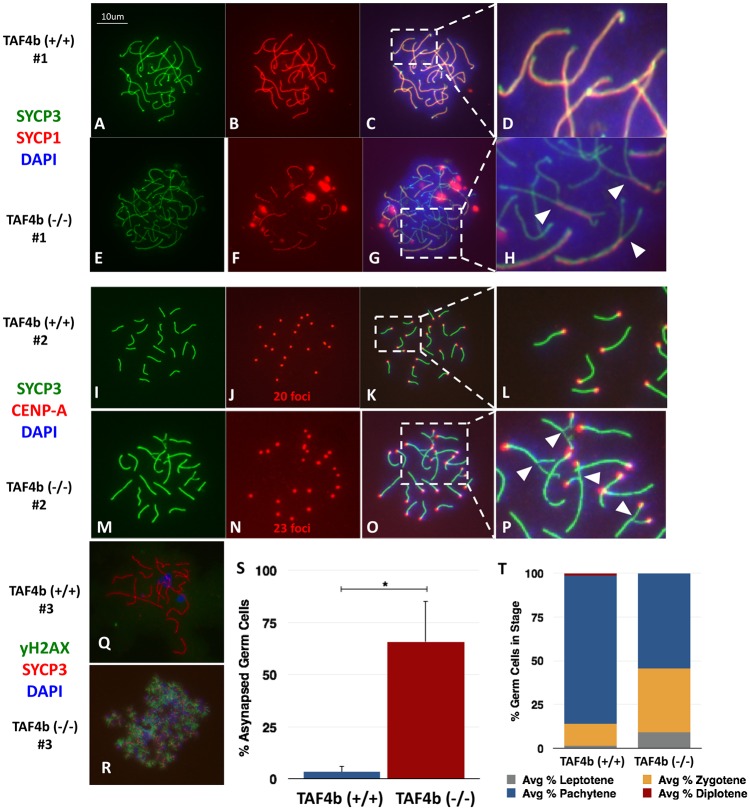
Taf4b-deficient oocytes experience defective meiotic progression and chromosome asynapsis.Pachytene spreads were prepared using the drying-down technique (50) on cell suspensions from E16.5 wild-type (A-D; I-L) and Taf4b-deficient (E-H; M-P) ovaries. Slides were stained for SYCP1 and SYCP3 (A-H), or SYCP3 and CENP-A (I-P). White arrowheads in (H) indicate regions of asynapsis in which SYCP3 is localized but SYCP1 is not; while white arrowheads in (P) indicate regions of asynapsis, many of which can be visualized by non-overlapping CENP-A centromeric foci. Slides were also stained for γH2AX and SYCP3 (Q, R) to visualize double-strand breaks. A high incidence of asynapsis (S), as scored by >20 CENP-A foci, as well as defects in meiotic progression (T), as scored by SYCP3 configuration (S1 Fig), were apparent in Taf4b-deficient oocytes. *: n = 4 animals each, one-tailed t-test, p<0.05